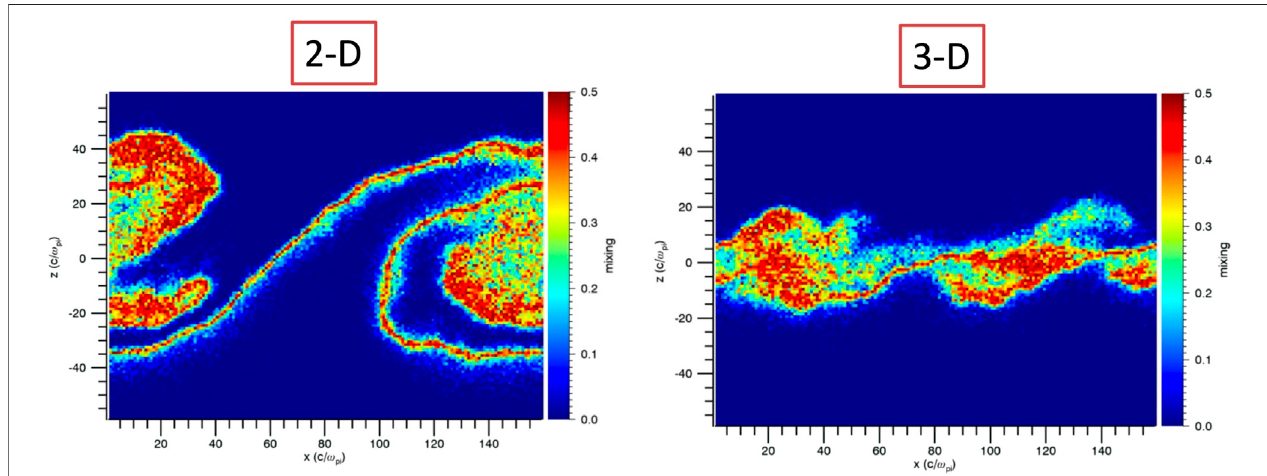
FIGURE 8 | Comparison of 2D and 3D hybrid simulations. The 2-D result shows a coherent m (cid:2) 1 vortex structure while the 3-D case does not exhibit a coherent rolled up structure and at the same time appears as an m (cid:2) 2 mode.